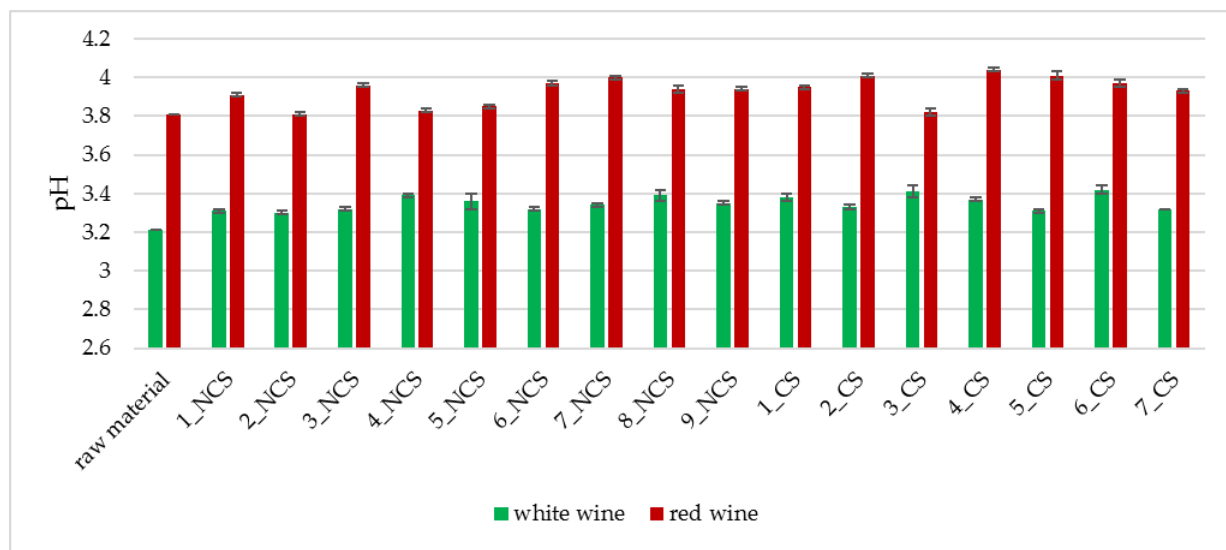
Figure 3. pH values of white and red wines.